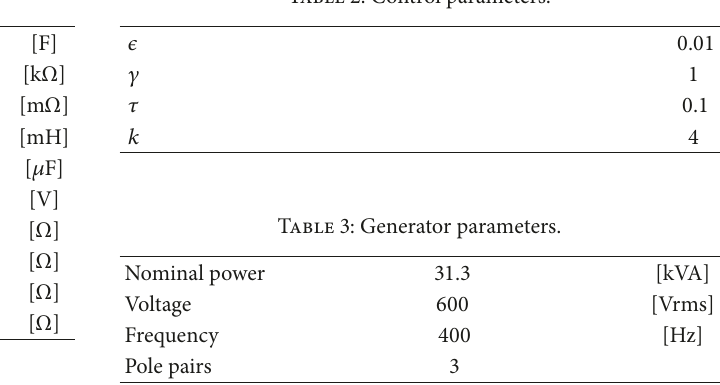
Table 1: Model parameters. Table 2: Control parameters.